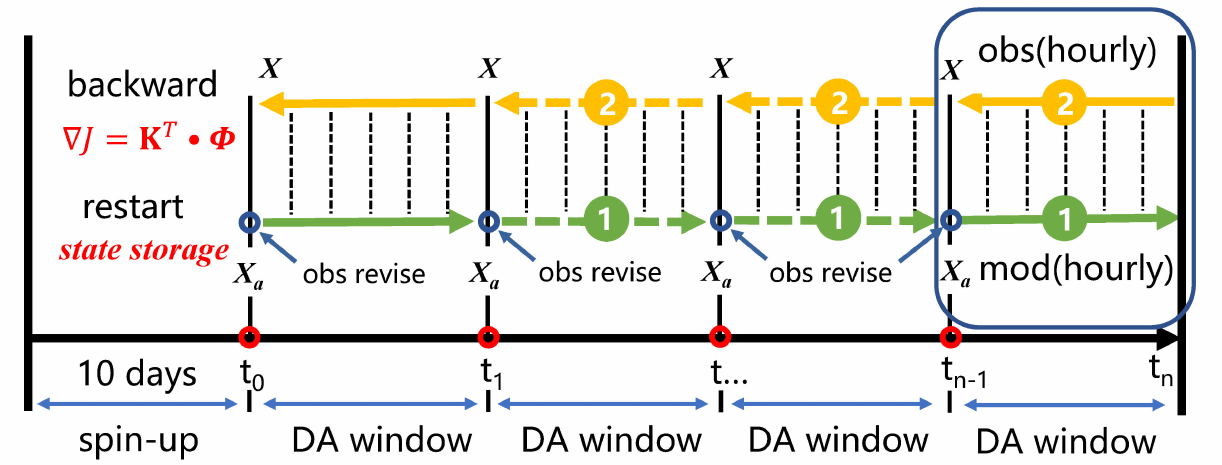
Figure 2. The flowchart of the CUACE-4DVar time-resolved emission inversion system. Generally, the cost function J is defined by the following equation, including observa- tion and background